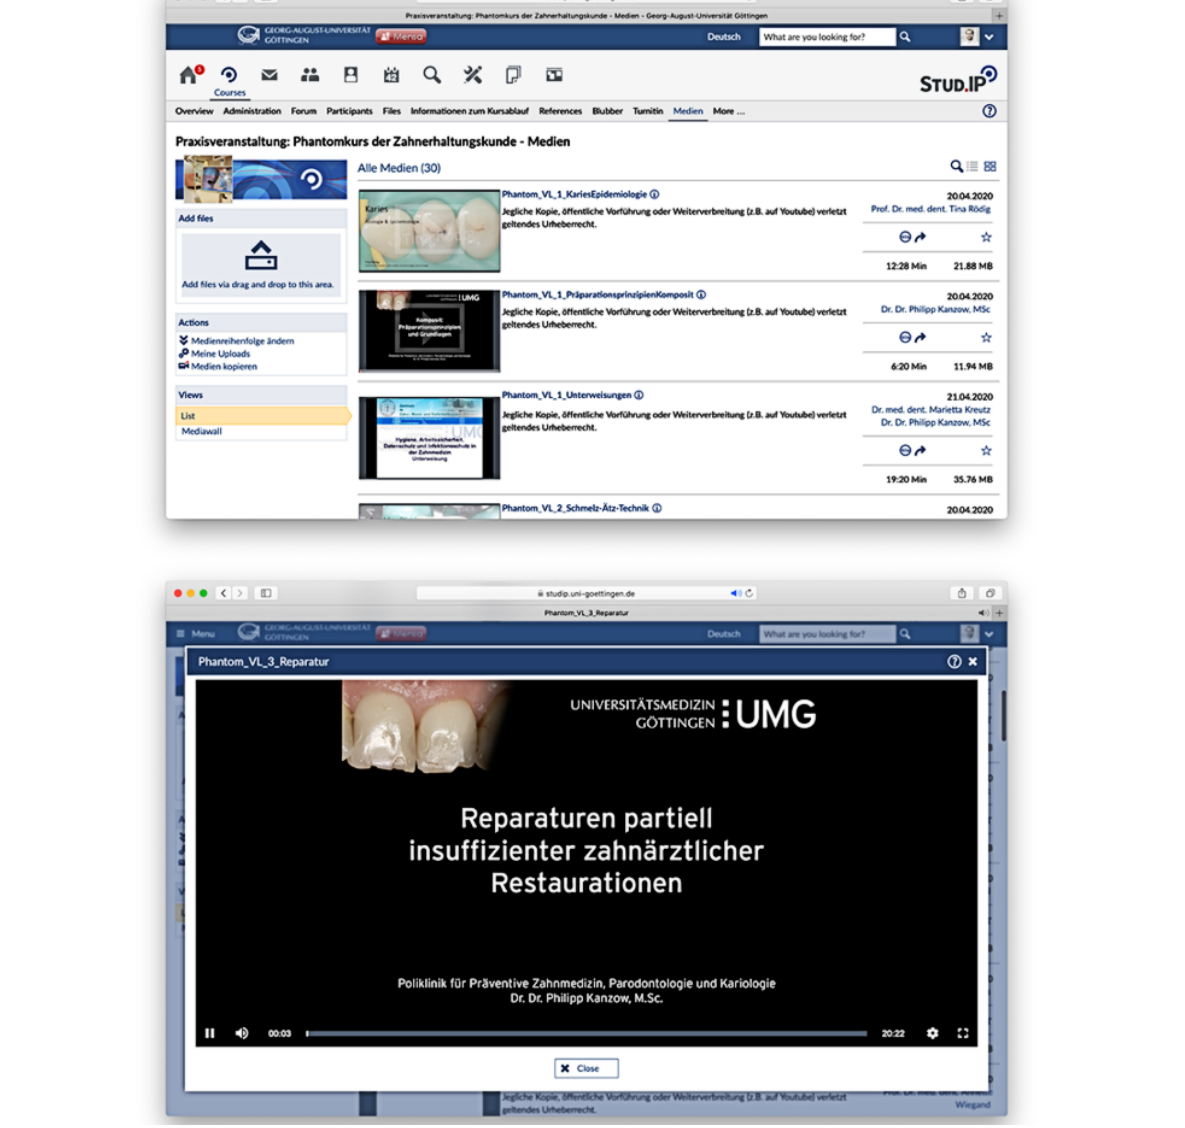
P valuePeriodontologyEndodontologyCariology, Restorative Den-